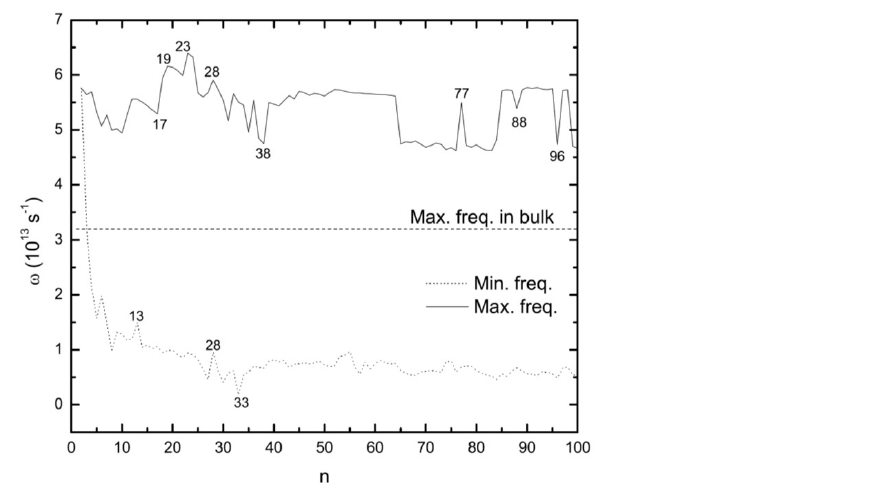
Figure 13. Maxima and minima of vibrational frequencies for the optimized Ag n clusters. The dashed line shows the maximum value of the vibrational frequencies for bulk